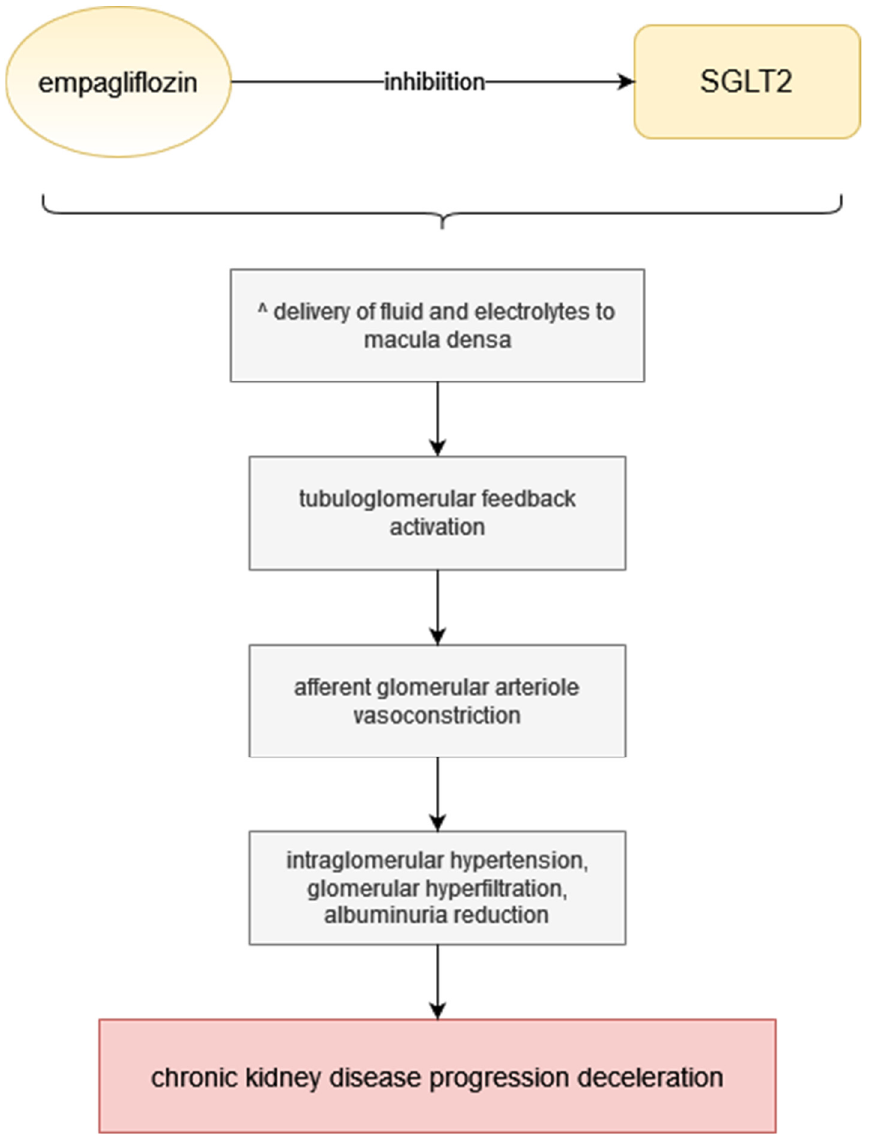
Figure 1. Empagliflozin mechanism of action. Step by step visualisation of action from SGLT inhibition to chronic kidney disease progression deceleration.